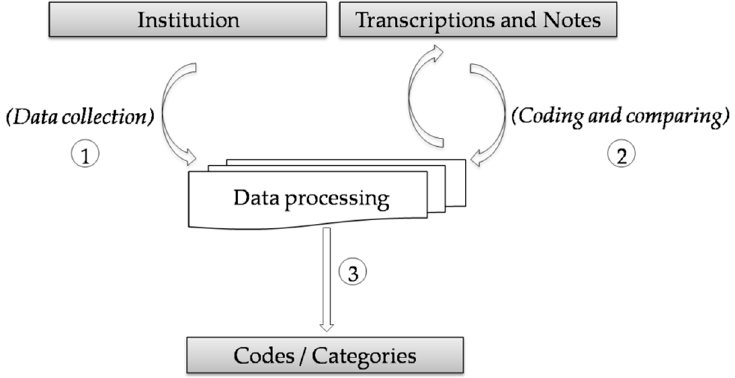
Figure 2. Coding and categorization process.